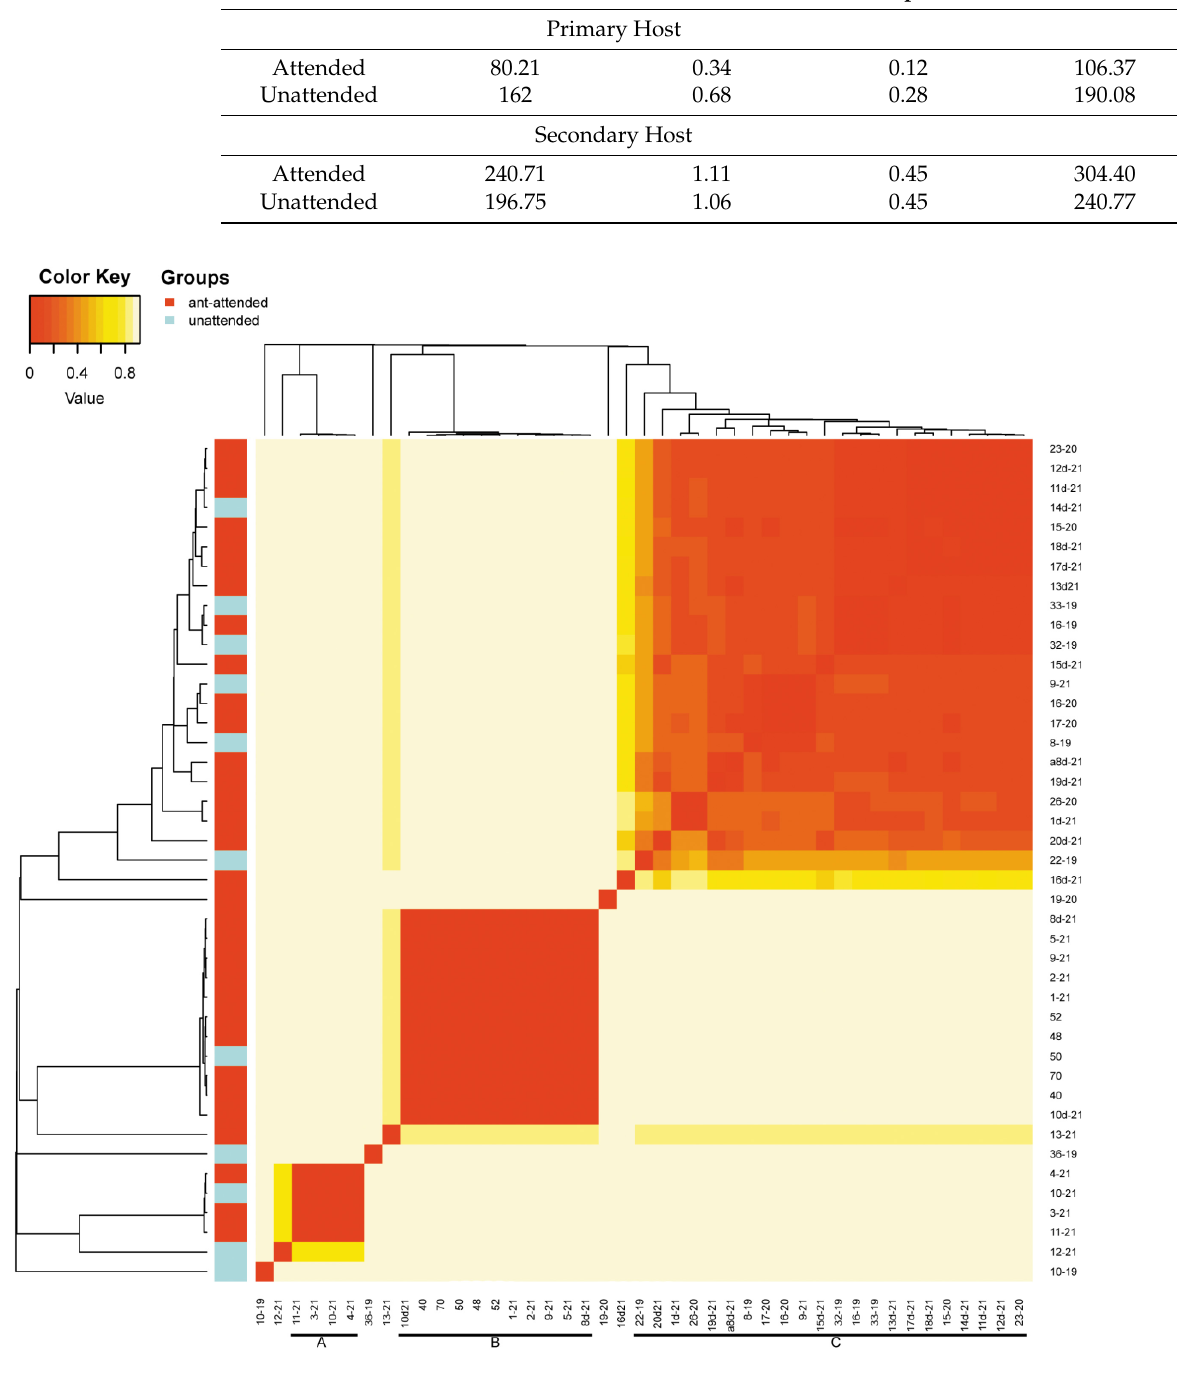
Figure 4. Heatmap of OTU beta diversity clustered with the Bray method in reference to the ant attendance of studied samples (sample numbers as in Supplementary Table S1; bars with letters mark clades).